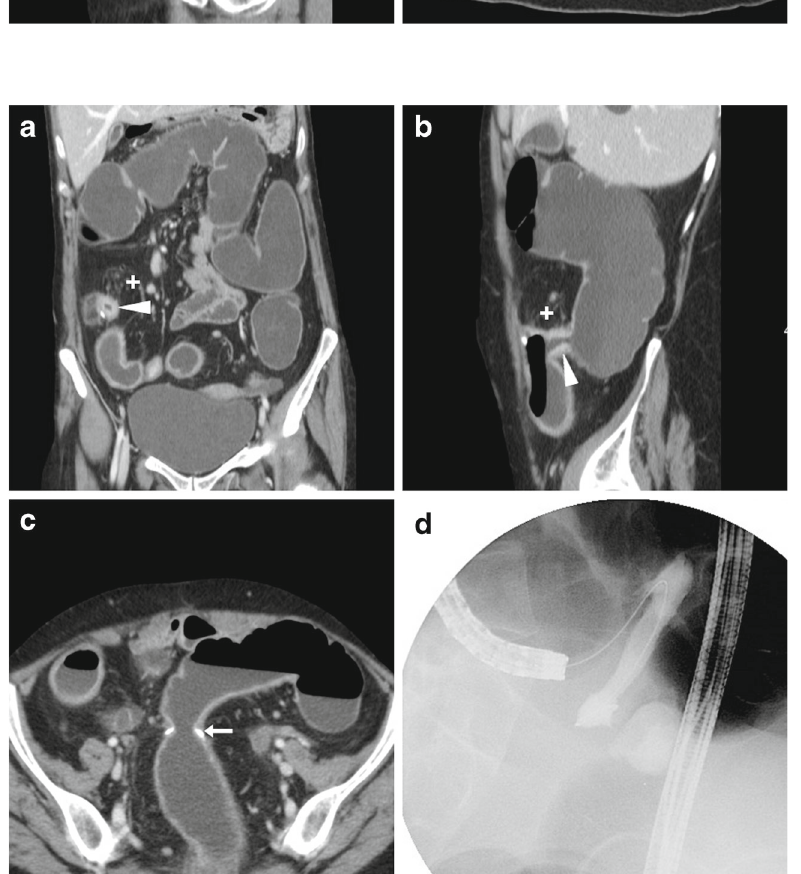
Fig. 14 Two cases of recurrent CD after ileo-colic resection. a – b Proximally to the ileo-colic anastomosis (arrows), the neoterminal ileum (arrowheads) does not distend retrogradely during WE-MDCT and shows thickened walls with enhancing mucosa and perivisceral vascular engorgement ( B comb sign ^ , +). c – d Proximally to the well- distended colon, the ileo-colic anastomosis (arrows) appears moderately patent (arrows). Recurrent CD is depicted as segmental, homogeneously enhancing mural thickening (arrowheads) with mucosal irregularities